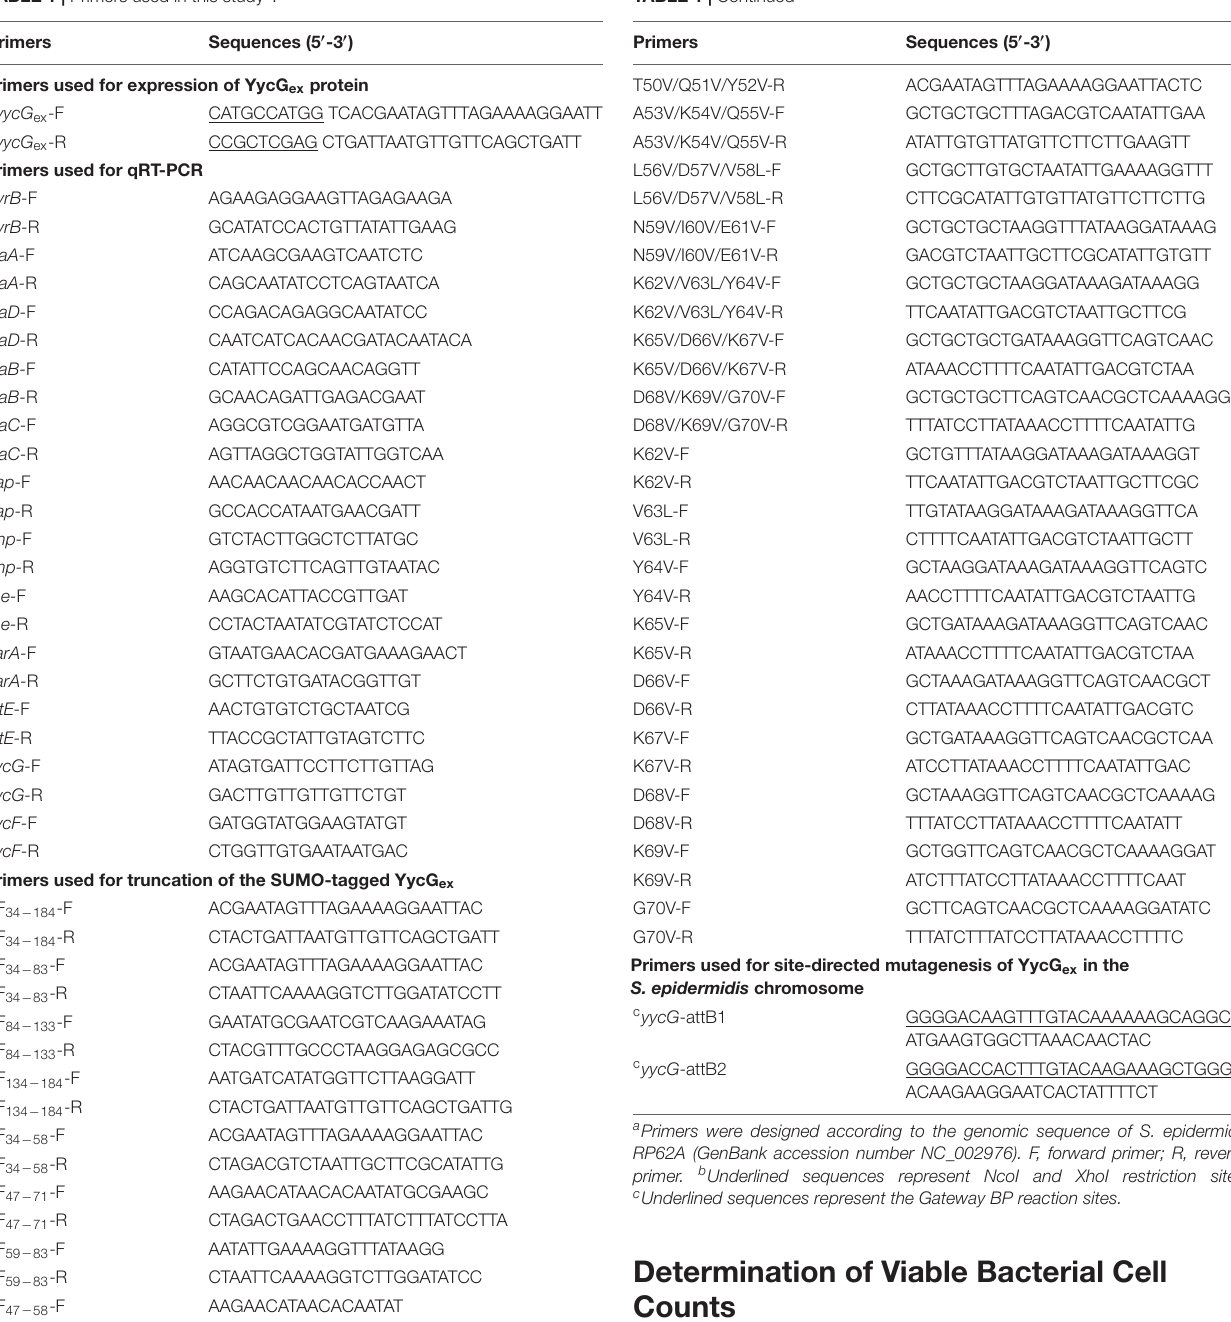
TABLE 1 | Primers used in this study a